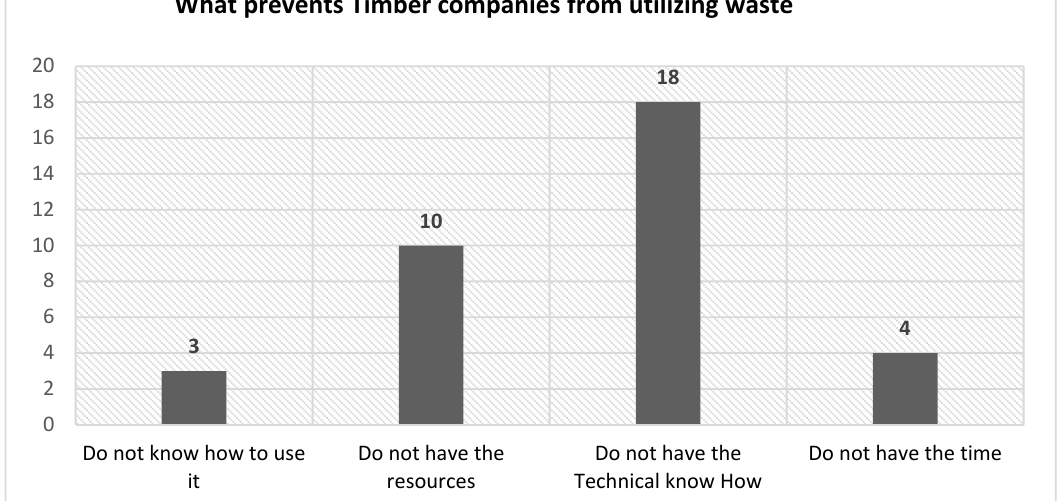
Figure 5. Obstacles in utilizing wood waste by timber production companies.